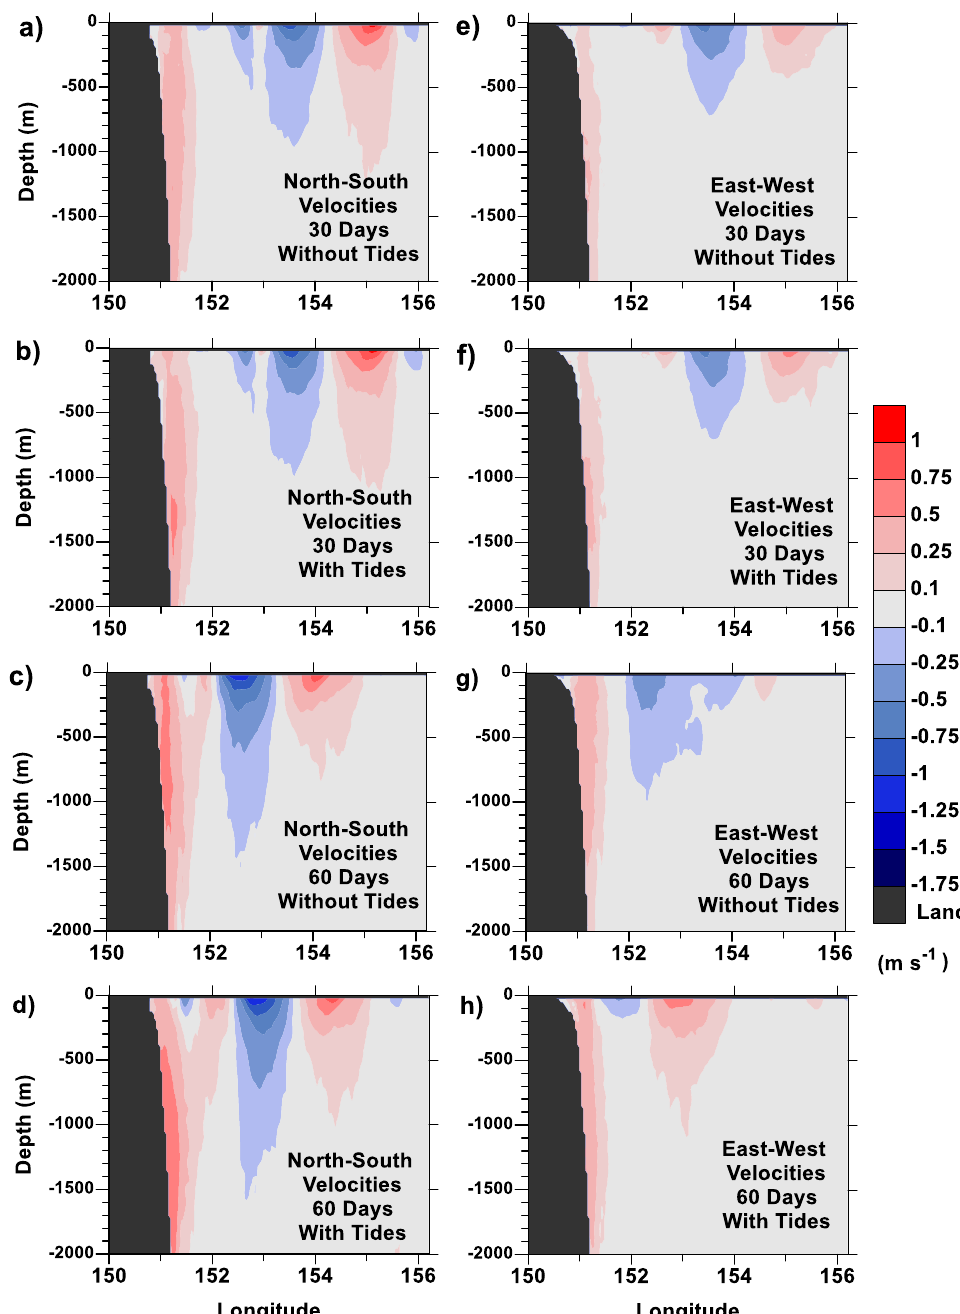
Fig. 12 Vertical transects in longitude at 35 o 15’S of the North–South velocities for the a non-tidal and b tidal simulations at 30 days and c and d at 60 days, respectively, and of the East–West velocities for the e non-tidal and f tidal simulations at 30 days and g and h at 60 days,